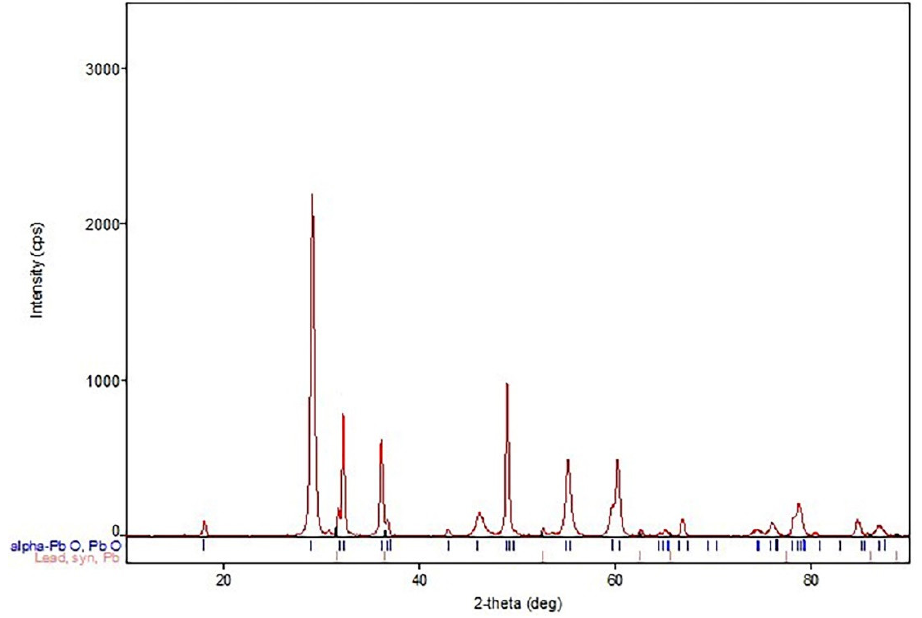
Figure 15. XRD analysis of lead oxide.